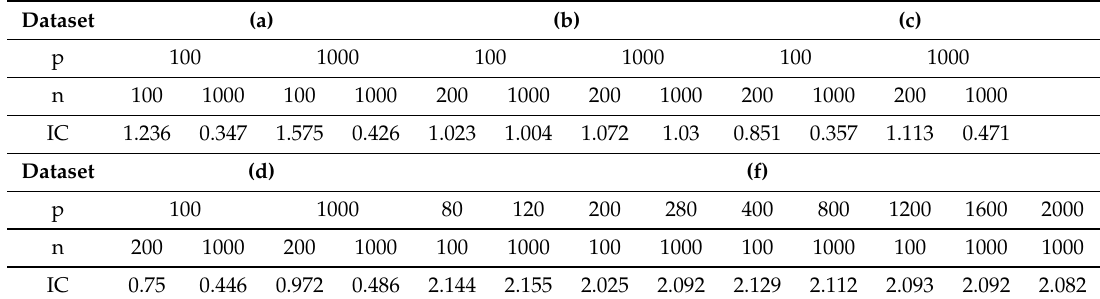
Figure 8. dataset (f): ( a ) Average number of selected variables (increasing lines) and MCE (decreasing lines) for LASSO (dashed) and RVM (continuous). ( b ) MCE for LASSO (dashed) and RVM (solid). Table 2. LASSO Irrepresentable Condition for the simulated datasets (a)–(d),